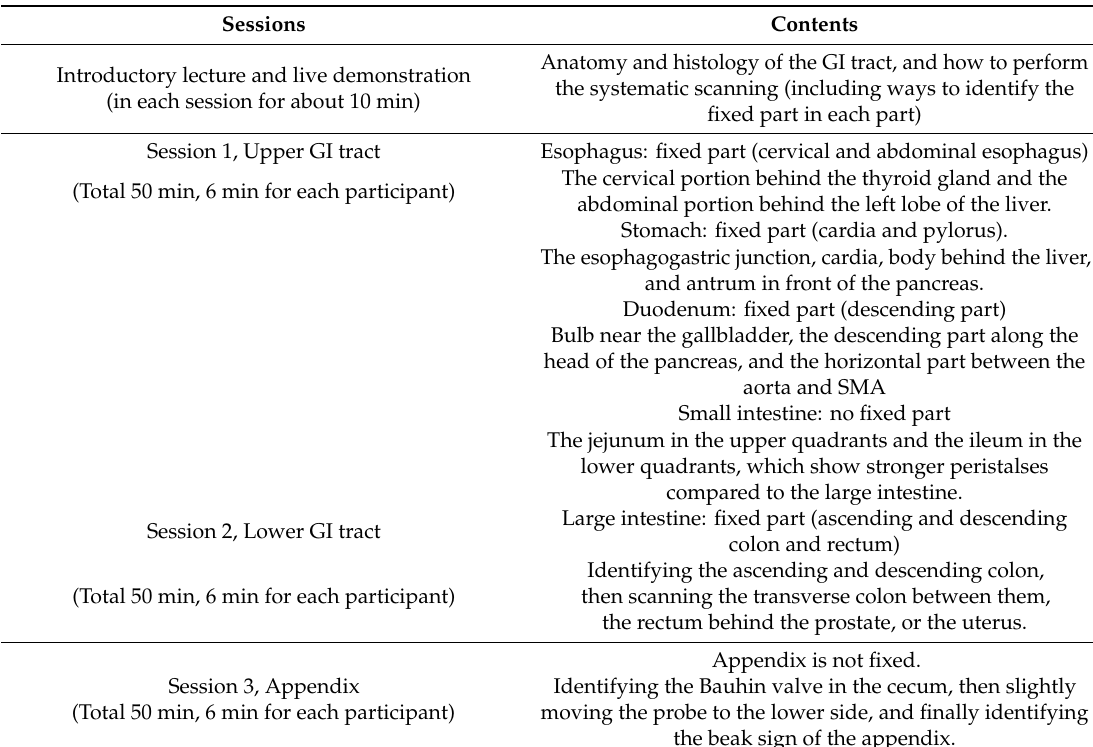
Table 1. Overview of the hands-on